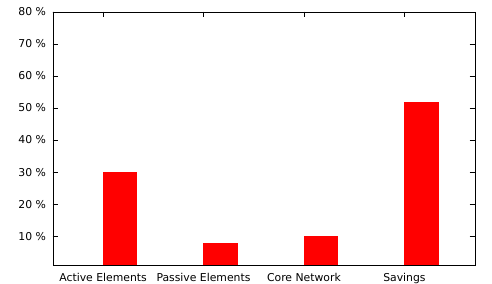
Figure 6. Investment savings in cloud-based mobile network.